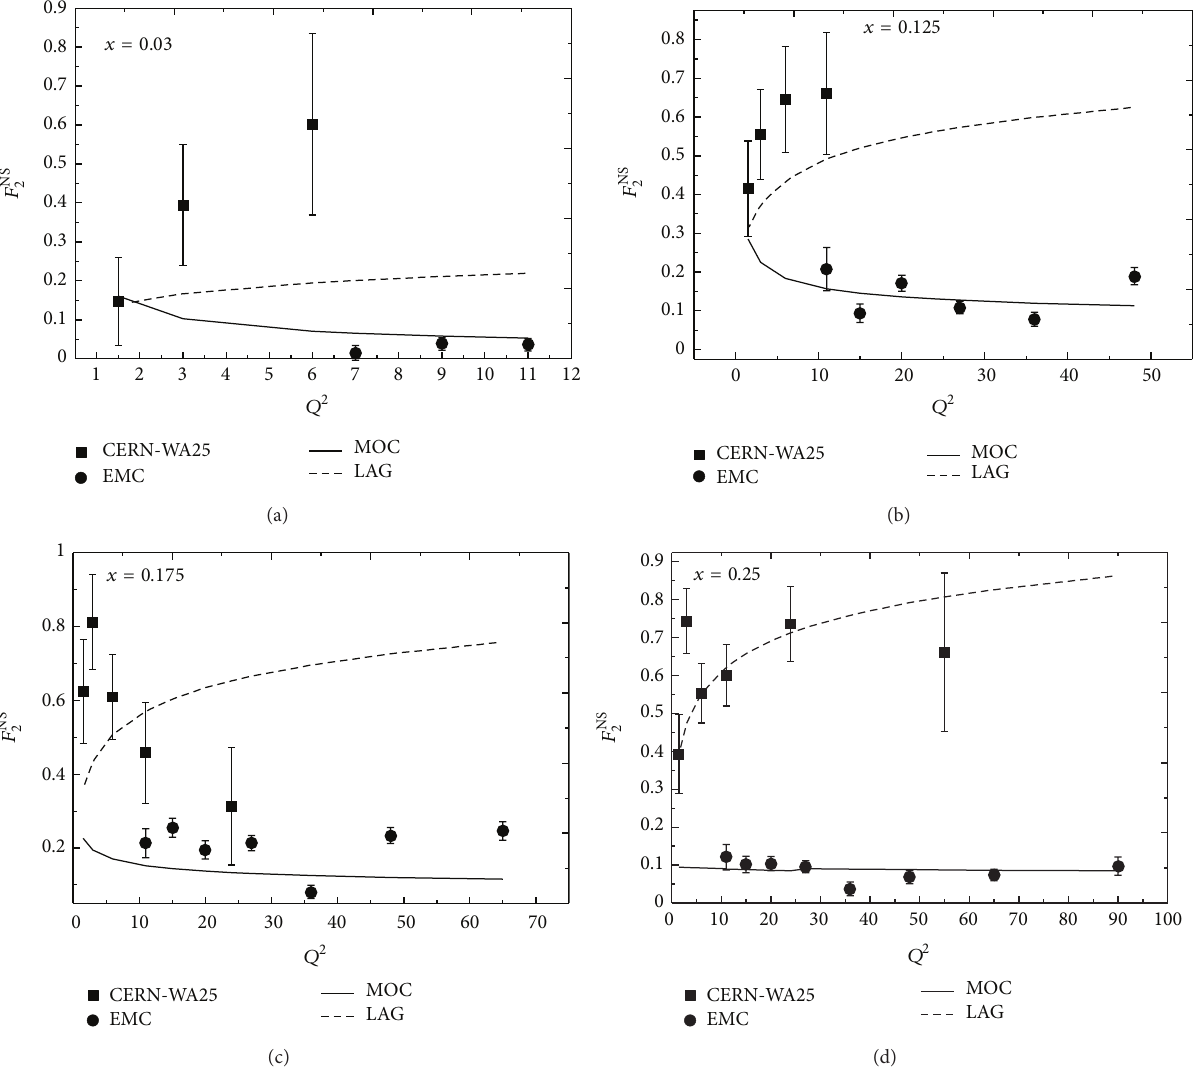
Figure 2: Nonsinglet structure function 𝐹 NS 2 (𝑥,𝑄 2 ) as a function of 𝑄 2 at different fixed 𝑥 according to (19) and (45). Data from [19, 20].